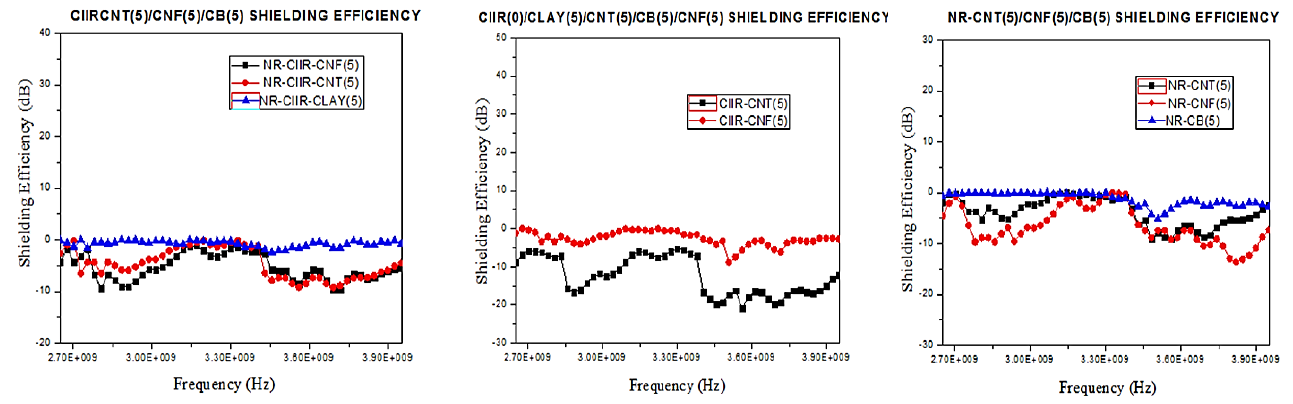
Figure 16. EMI shielding effectiveness frequency dependencies of CIIR-NR, CIIR, and NR rubber nanocomposites with different filler.